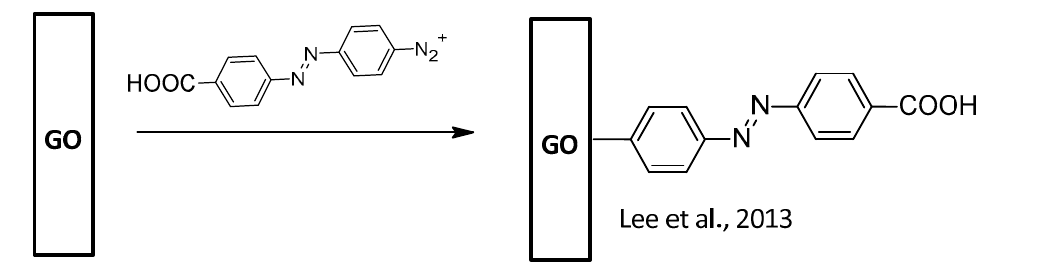
Figure 9. Covalent bonding of AZO on GO [104].